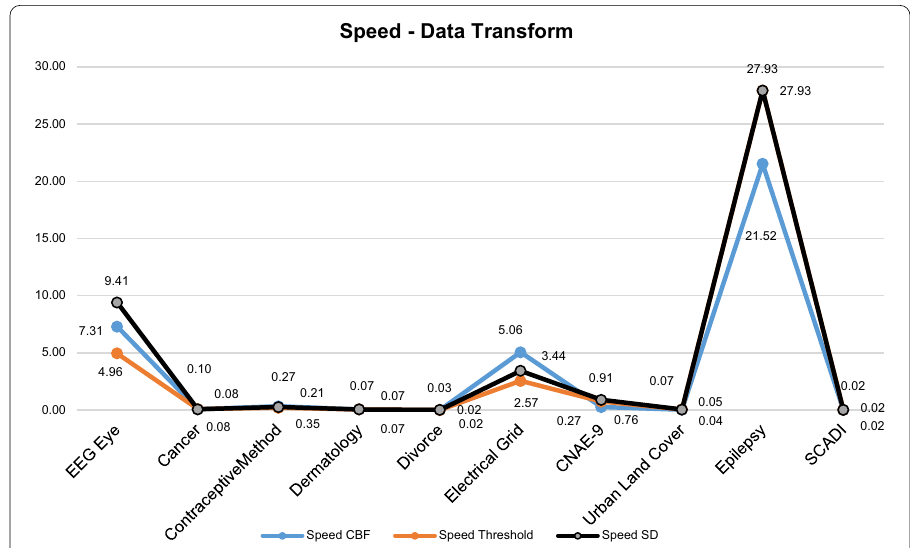
Fig.5 Comparison of the average time required for the transformation dataset